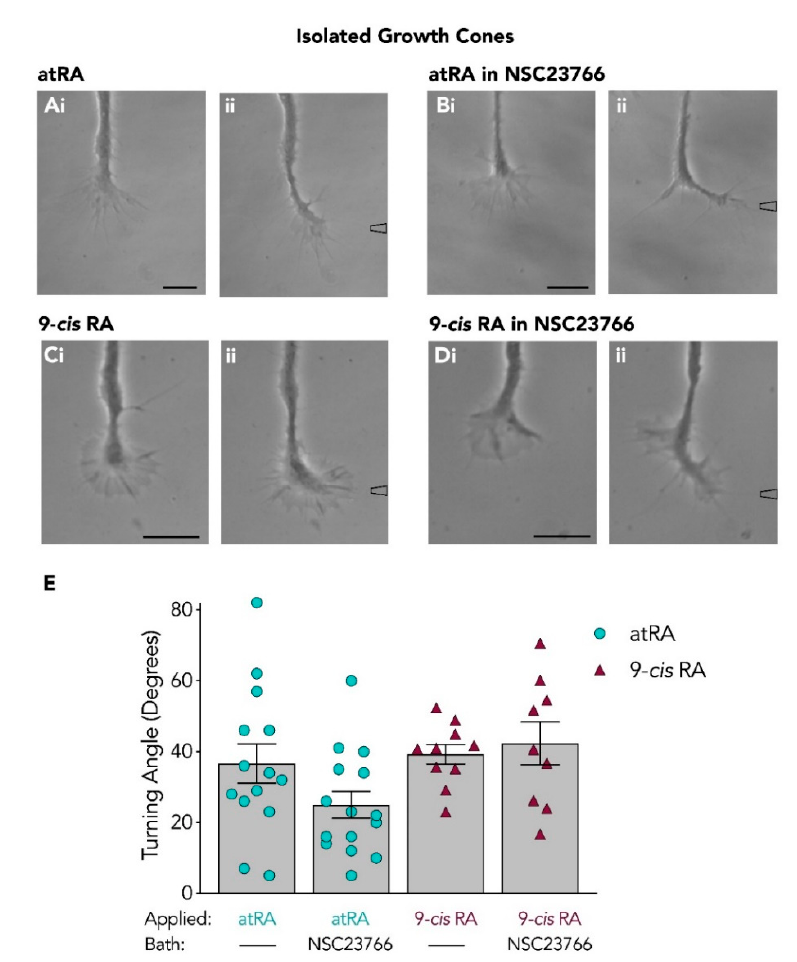
Figure 5. Isolated growth cones continue to turn toward retinoids in the presence of the Rac inhibitor. Representative images depicting the turning response of isolated growth cones to atRA ( Ai – ii ; n = 14; t = 30) or 9- cis RA ( Ci – ii ; n = 10; t = 18) in the absence of the Rac inhibitor, NSC23766. In the presence of NSC23766, isolated growth cones continued to turn toward both atRA ( Bi – ii ; n = 15; t = 40) and 9- cis RA ( Di – ii ; n = 9; t = 15). Scale bars: 15 µ M. ( E ) Graph depicting the mean turning angles of isolated growth cones in response to atRA or 9- cis RA, in the presence or absence of